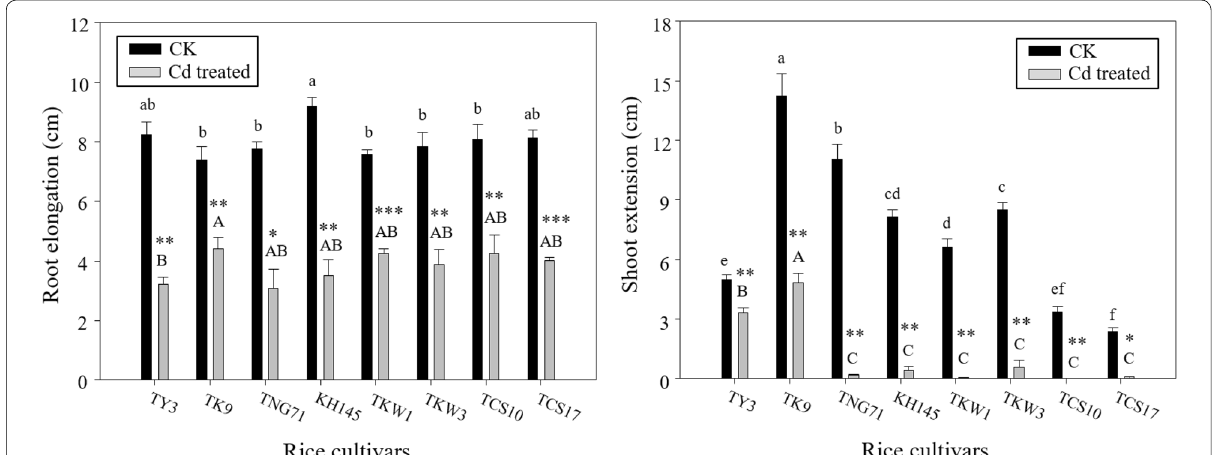
Fig. 2 Root elongation and shoot extension of the seedlings after a 7‑day exposure of 50 μM Cd (Cd treated) for the rice cultivars, TY3, TK9, TNG71, KH145, TKW1, TKW3, TCS10, and TCS17, and making comparison with a check (CK) for root elongation and shoot extension. Error bars represent the standard errors of the mean values (replicates n 3). Same lowercase letters above the black bars and same capital letters above the gray bars = indicate the mean values are not significantly different at p < 0.05 among the cultivars according to the last significant difference (LSD). *, **, and *** indicate significant differences at p < 0.05, p < 0.01, and p < 0.001 between Cd treated and CK by the